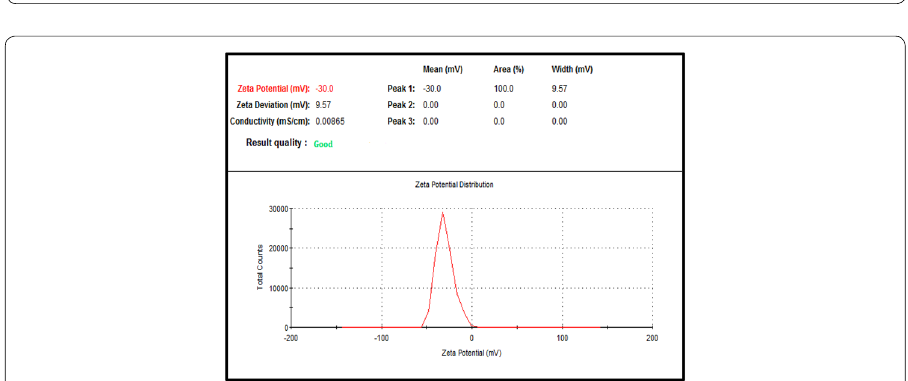
Fig. 3 Zeta potential of optimized nanoemulsion batch